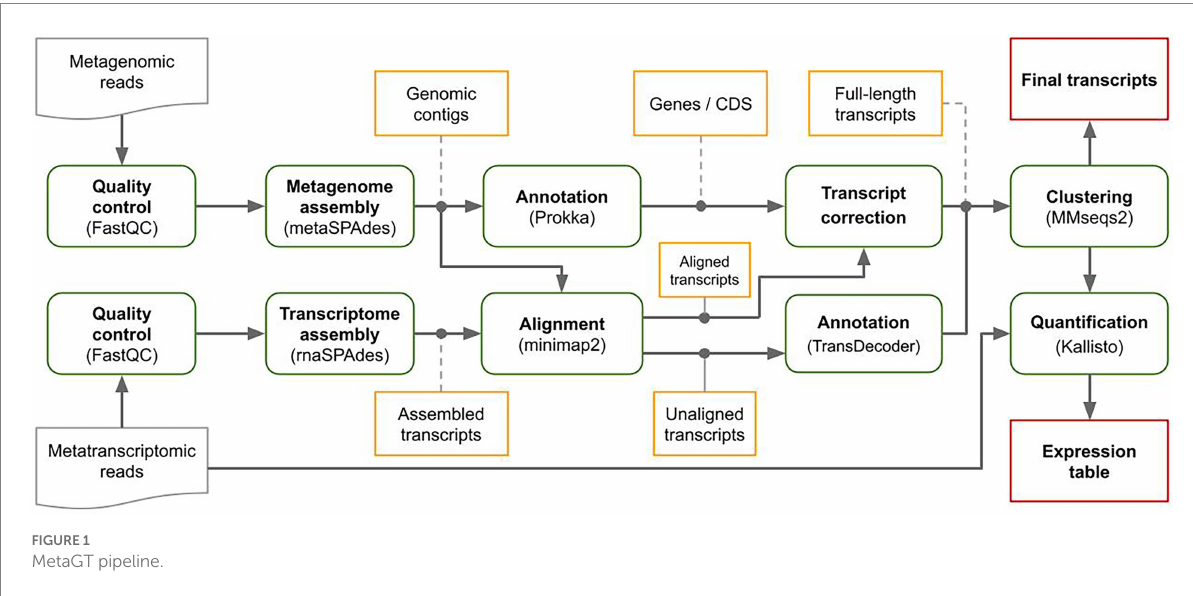
FIGURE 1 MetaGT